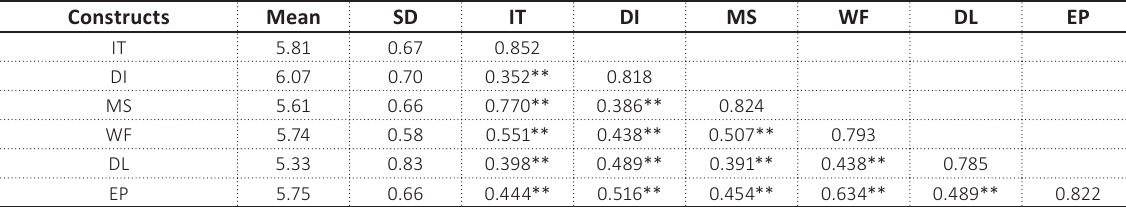
Table 2. Correlation matrix for measurement scales